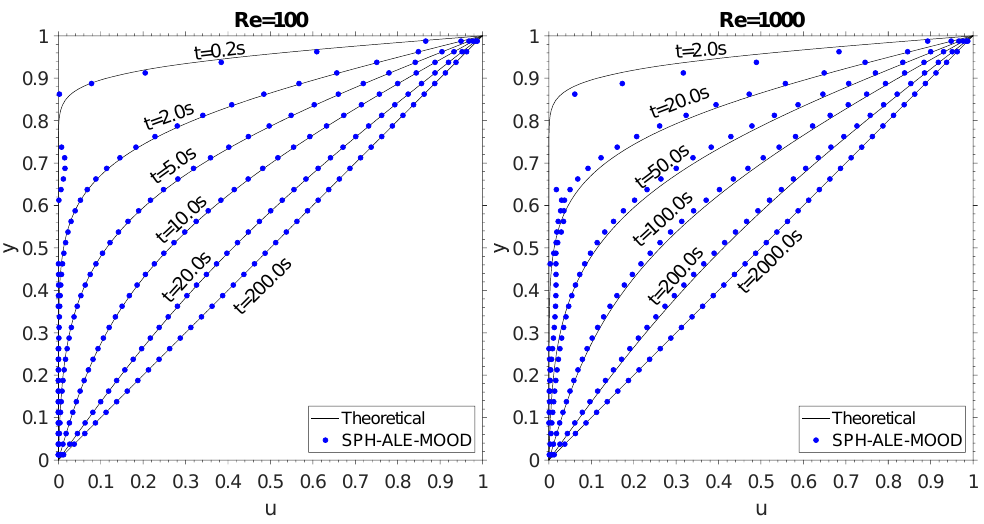
Figure 18. Time evolution of the velocity profile for the Couette flow Re = 1 ( top left ), Re = 10 ( top right ), Re = 100 ( bottom left ), and Re = 1000 ( bottom right ). The numerical solution is compared with the exact solution presented in Equation (17).